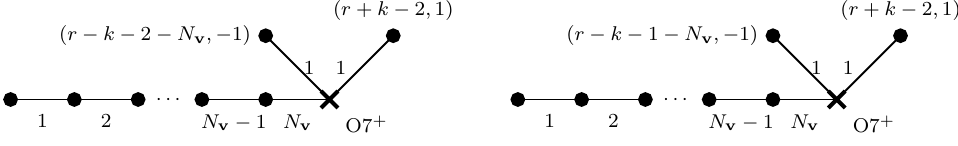
Figure 3 . Brane webs for SO ( N ) + N v hypermultiplets in the vector representation at infinite gauge coupling after taking all mass parameters to zero for N = 2 r (left) and N = 2 r + 1 (right). From here onwards we will not indicate the monodromy cut associated with the 7-brane explicitly for ease of